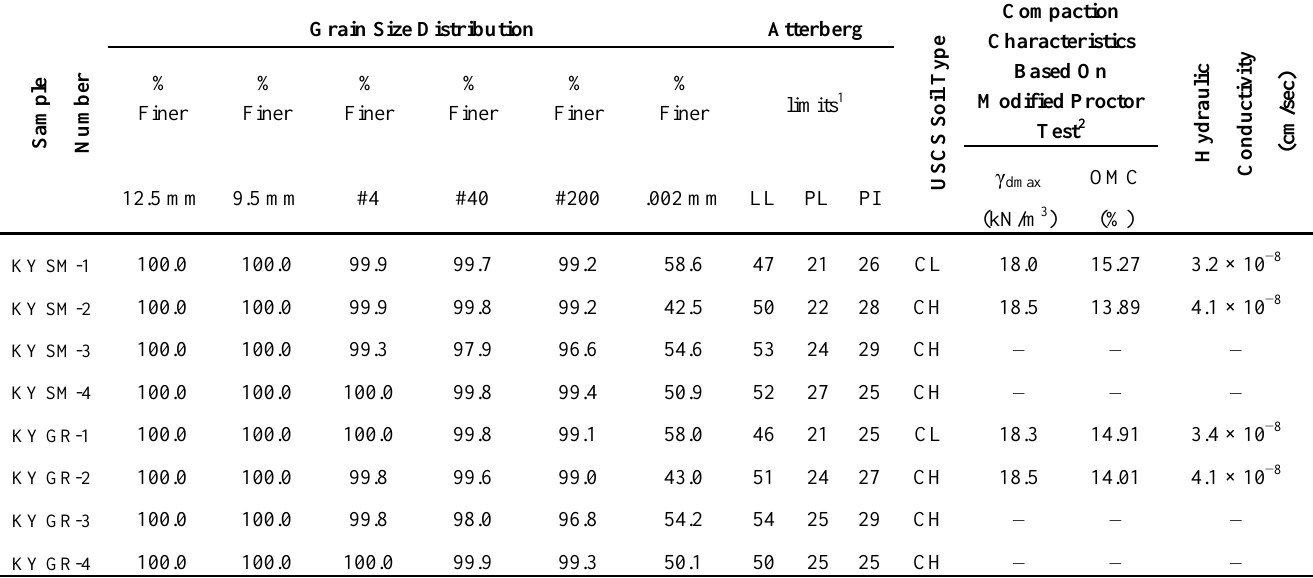
Table 5. Geotechnical characteristics of stockpiled mined clay-samples from Central Kentucky processed manually and using a soil grinder.